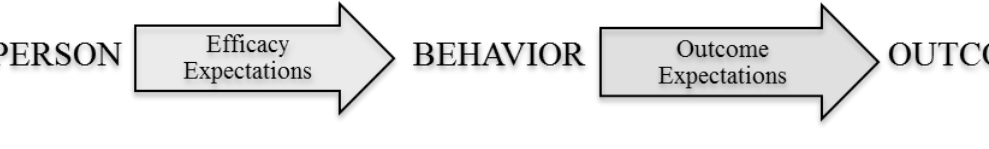
Figure 1. The difference between efficacy expectations and outcome expectations (Bandura,